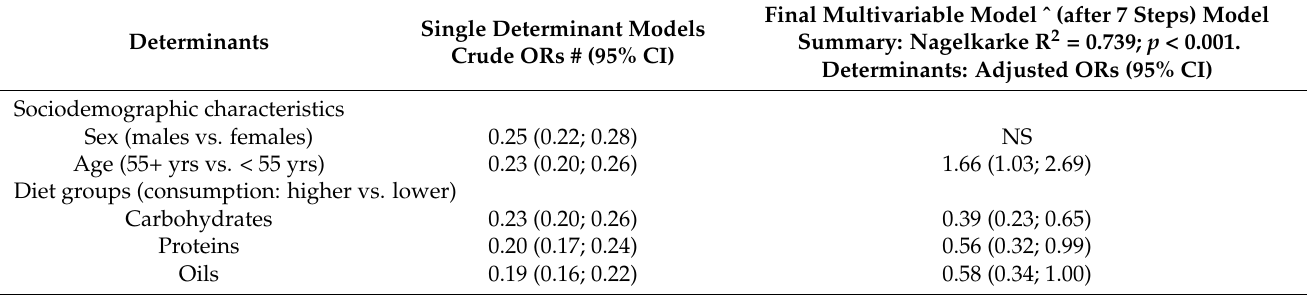
Table 4. Association between major diet groups and xerostomia adjusted with sociodemographic characteristics in adults. Final Multivariable Model ˆ (after 7 Steps) Model Single Determinant Models Determinants Summary: Nagelkarke R 2 = 0.739; p < 0.001. Crude ORs # (95% CI) Determinants: Adjusted ORs (95% CI) Sociodemographic characteristics Sex (males vs.